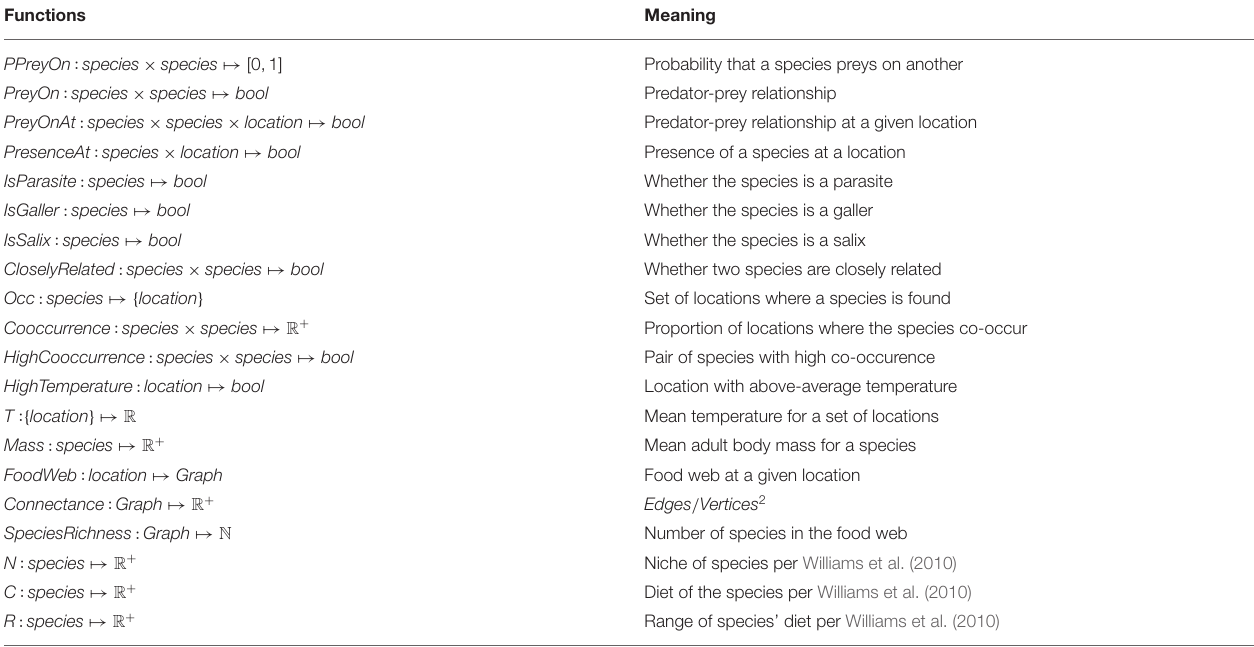
TABLE 4 | Predicates and functions used for the Salix example.